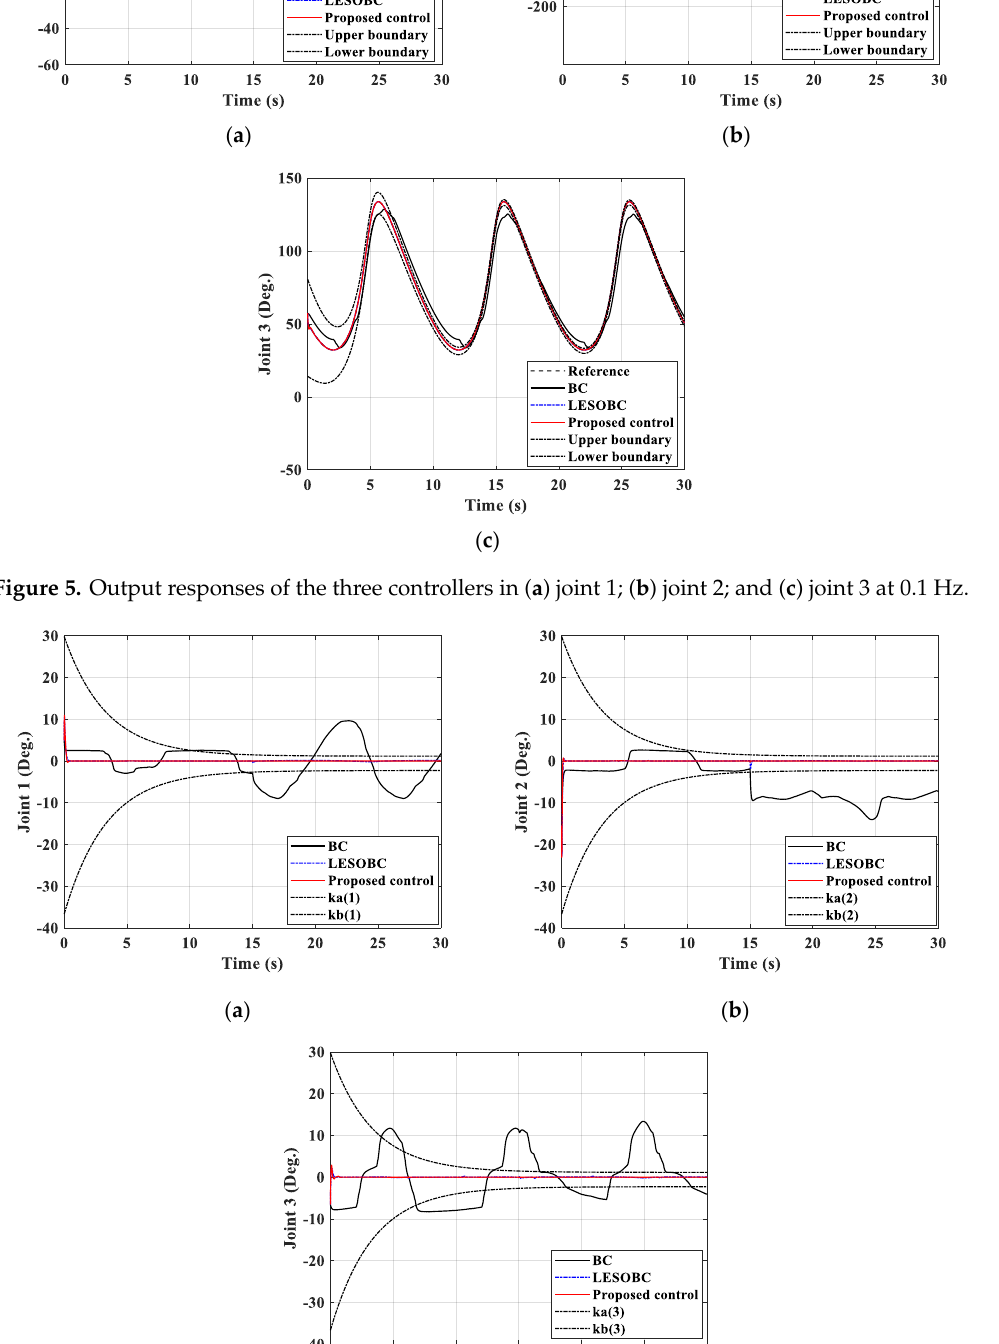
Figure 6. Error responses of the three controllers in ( a ) joint 1; ( b ) joint 2; and ( c ) joint 3 at 0.1 Hz. x The responses of the lumped uncertainties, 3 , at three joints are illustrated in Figure 7a with a dashed blue line, dashed dot black line, and dashed red line for joint 1, joint 2, and joint 3, respectively. In the first 15 s, the lumped uncertainties are unknown frictions at the joint space. In the last 15 s, an external force is applied at the end-effector along the x-axis. As a result, the uncertainties in each joint include not only the unknown friction but also the external disturbance. Therefore, they increased significantly and reduced the accuracy of the backstepping control. Figure 7b presents the estimated lumped disturbance, 3 ˆ x , which is the result of the LESO. Comparing to the lumped disturbance in Figure 7a, the results of the estimated lumped disturbance in Figure 7b proved that the LESO has a limited bandwidth, which means it cannot approximate the disturbance at high frequency. The accuracy of the LESOBC and proposed control is improved significantly by using LESO to estimate the lumped disturbance. The estimated results of the LESO are presented in Figure 8. The estimated errors in position, velocity, and lumped disturbance are bounded.